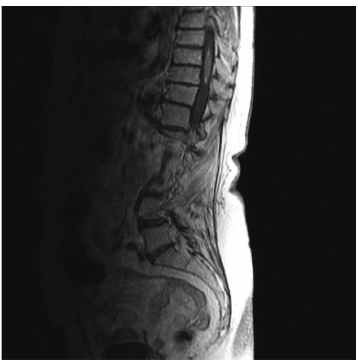
Figure 1: Thoracic MRI demonstrated a solitary intramedullary lesion at thoracic 9-10 level with homogeneous contrast enhance- ment in sagittal reconstruction.